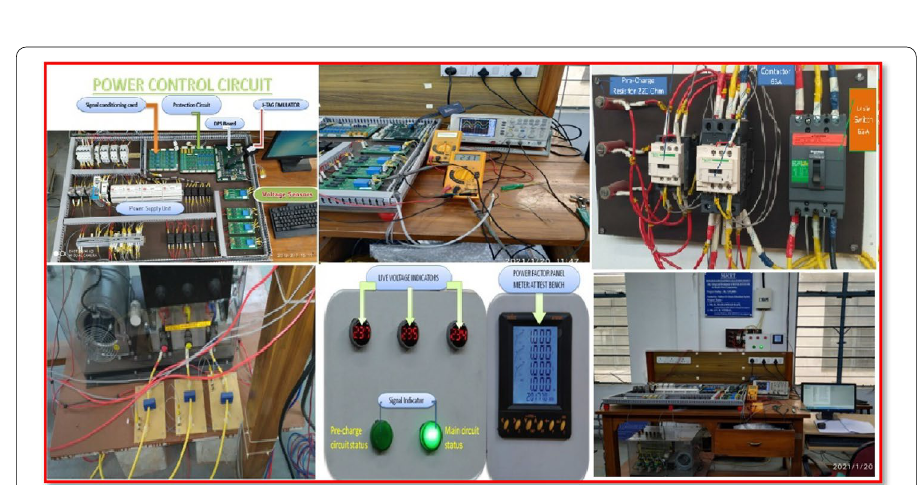
Fig. 30 Different photographs of the